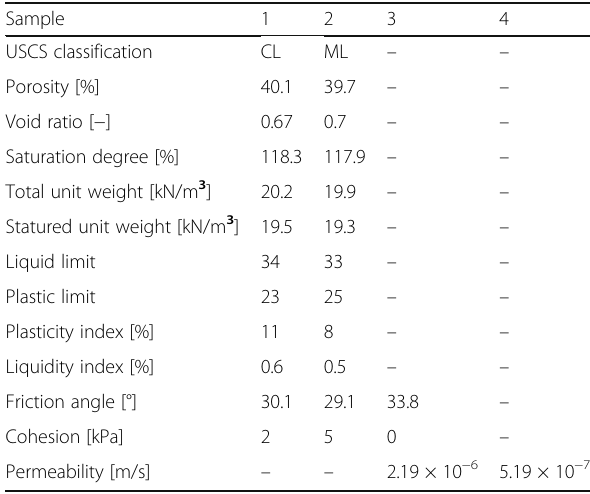
Table 1 Geotechnical parameters obtained from laboratory and in situ